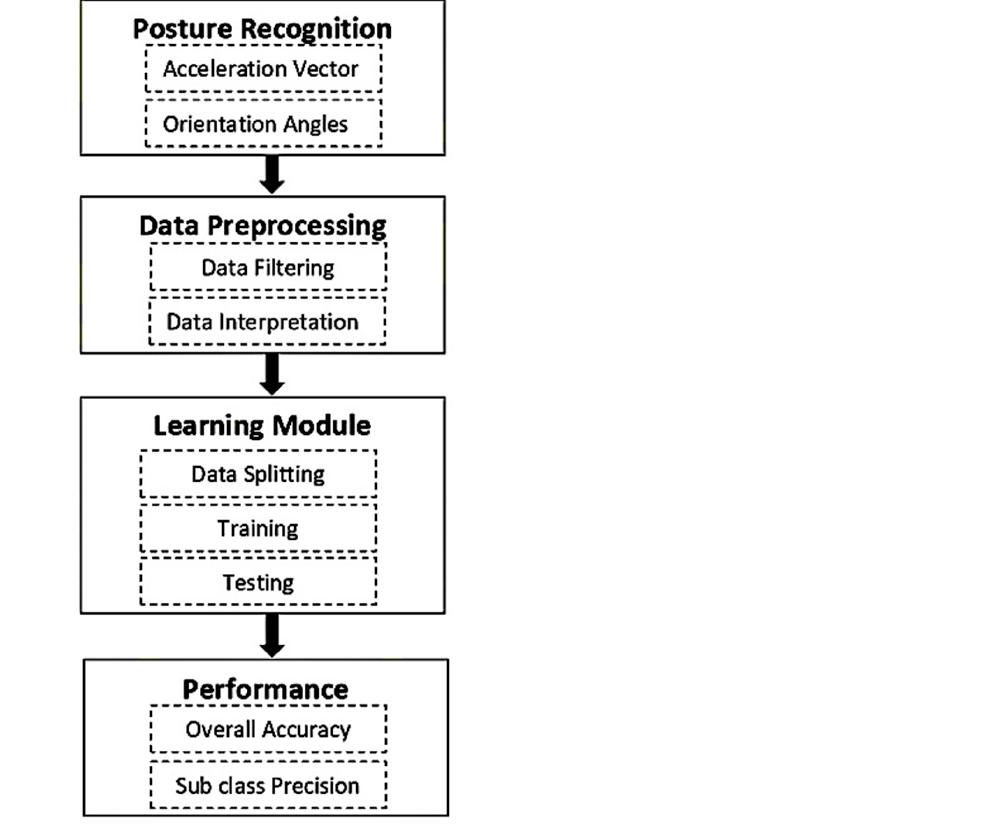
Figure 1. System architecture of the machine learning-based approach for detecting falls and fall-like motions.